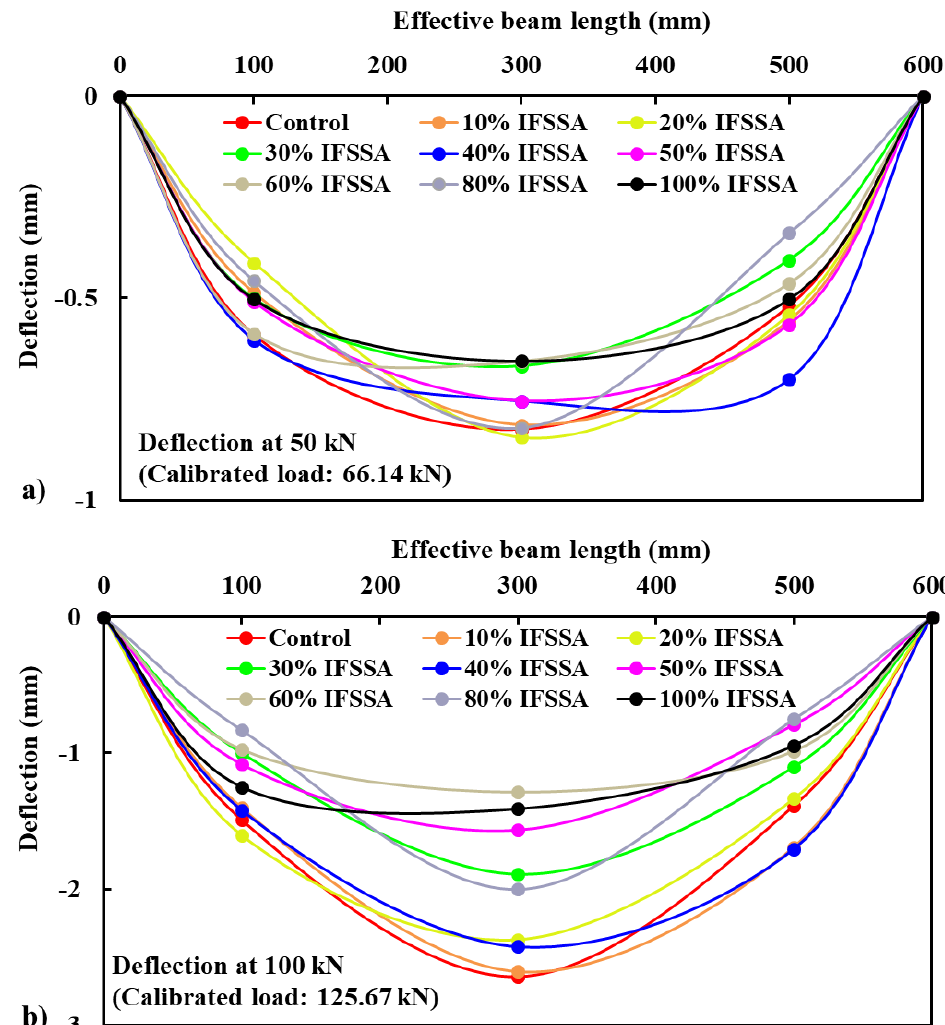
Figure 7. Deformed shape at the fixed flexural load of 50 kN ( a ) and 100 kN ( b ) of beams made with different replacement percentages of FCBA by IFSSA.